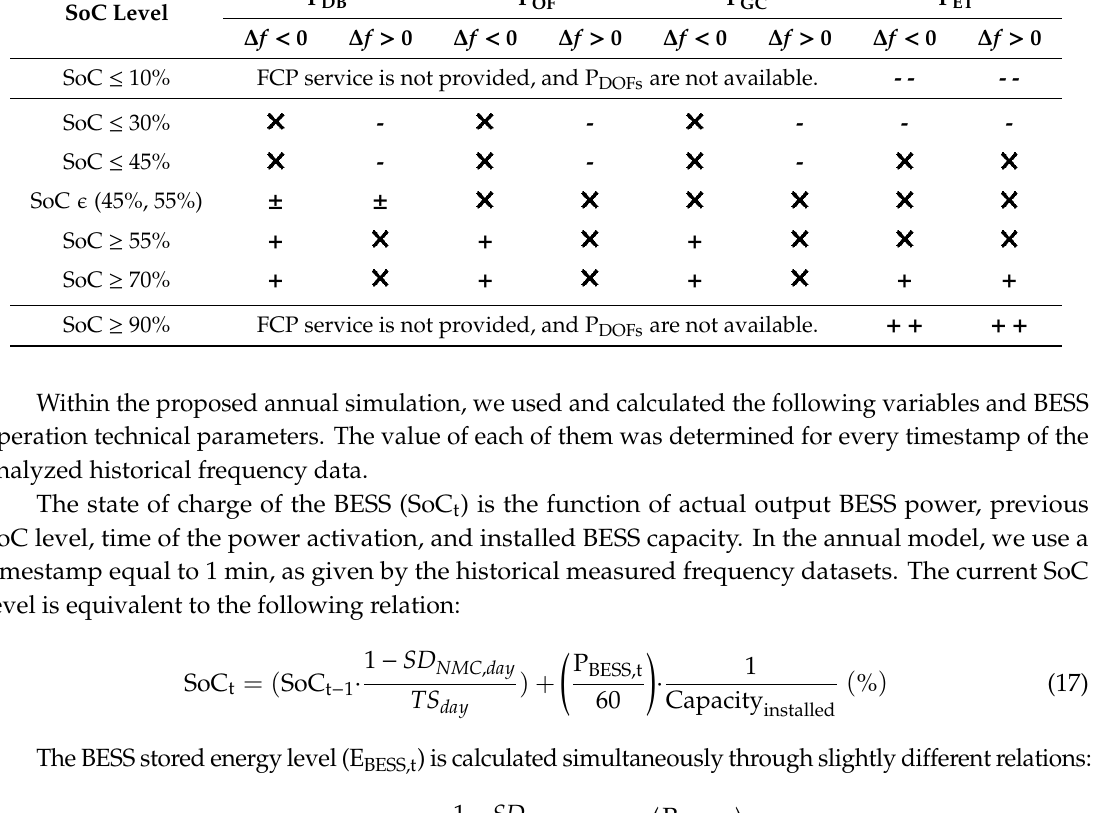
Table 4. Operation conditions for correction power degree of freedom DoF strategies.